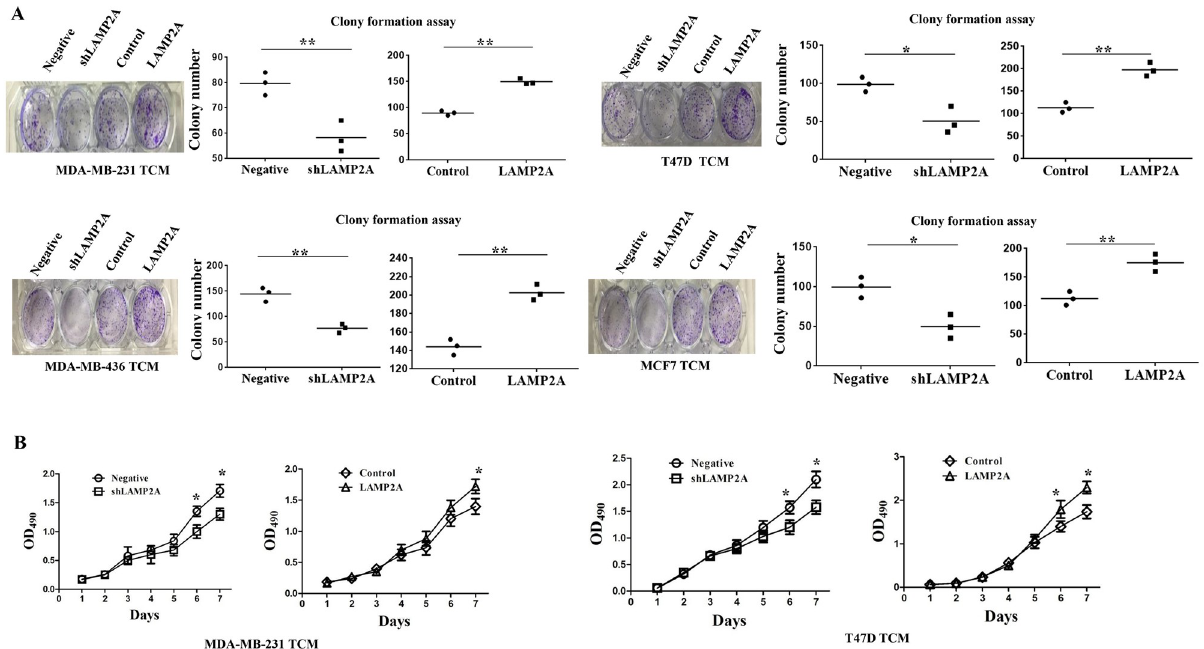
Fig 3. CMA promotes proliferation of HUVECs. (A) The proliferative capability of HUVECs was detected by colony formation assay. The cells were seeded onto 12-well plates, cocultured with TCM from breast cancer cells and allowed to form colonies for two weeks. (B) MTT assay was used to determine the proliferation rate of HUVECs cocultured with TCM at indicated timepoints. All values are representative of three different experiments; � P < 0.05 and �� P < 0.01.